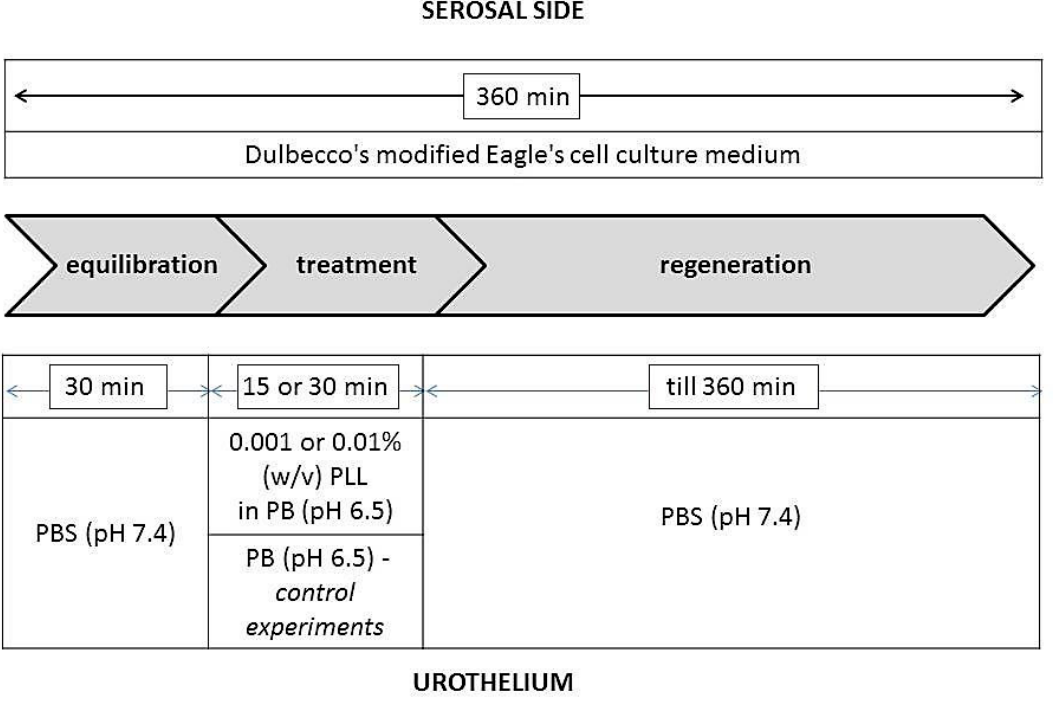
Figure 1. Schematic outline of the ex vivo experiments. Poly-L-lysine (PLL) with molecular weight 30–70 kDa or 70–150 kDa was used. PB = phosphate buffer.